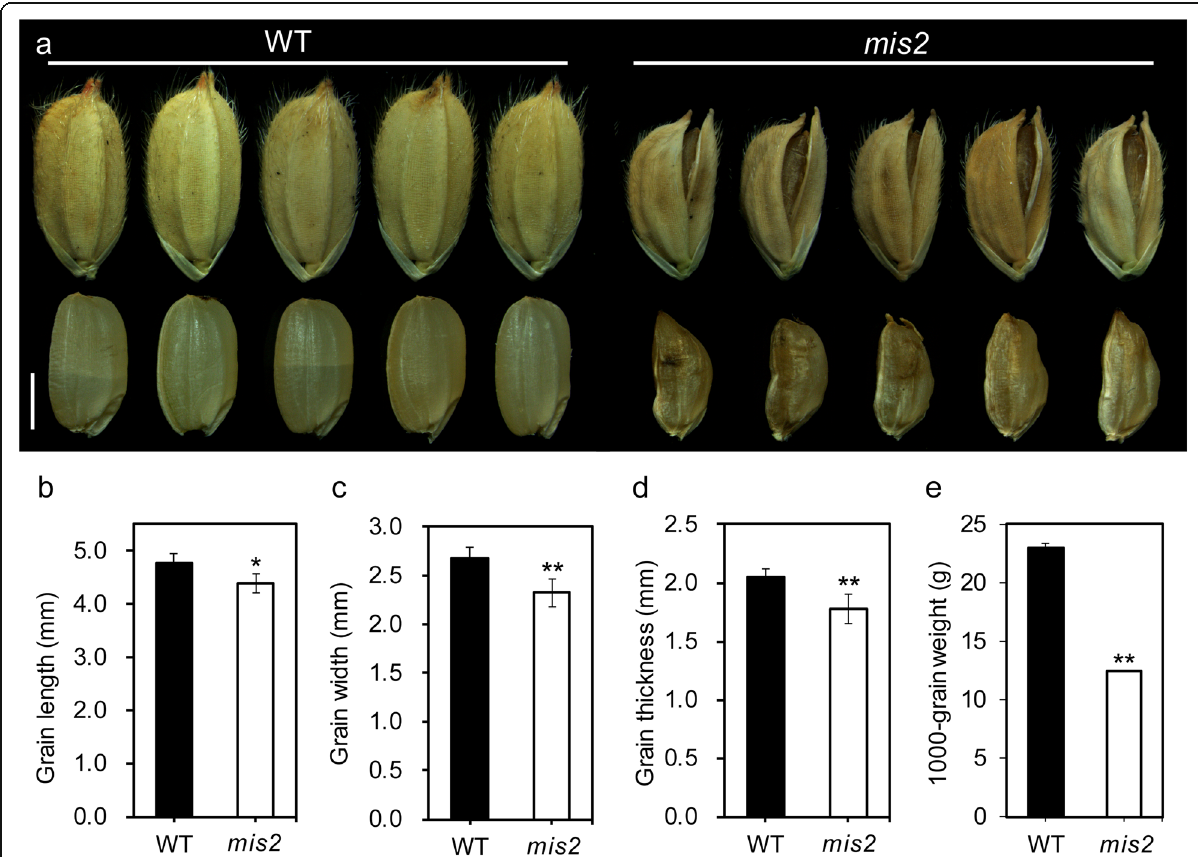
Fig. 1 Morphological characterization of the mis2 grains. ( a ) Mature grains from WT and mis2 . Upper: unhulled grains; Lower: hulled garins. Scale bar = 2 mm. ( b-e ) Quantification data of grain length ( b ), grain width ( c ), grain thickness ( d ) and 1000-grain weight ( e ) of WT and mis2 . * P < 0.05 and ** P < 0.01 by Student ’ s t test. Data are given as mean ± SD ( n =